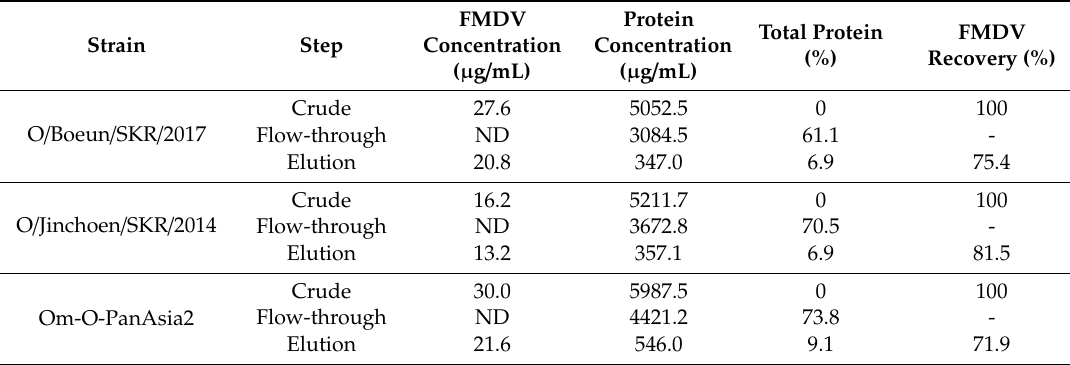
Table 1. Purification e ffi cacy by the HiTrap HP heparin